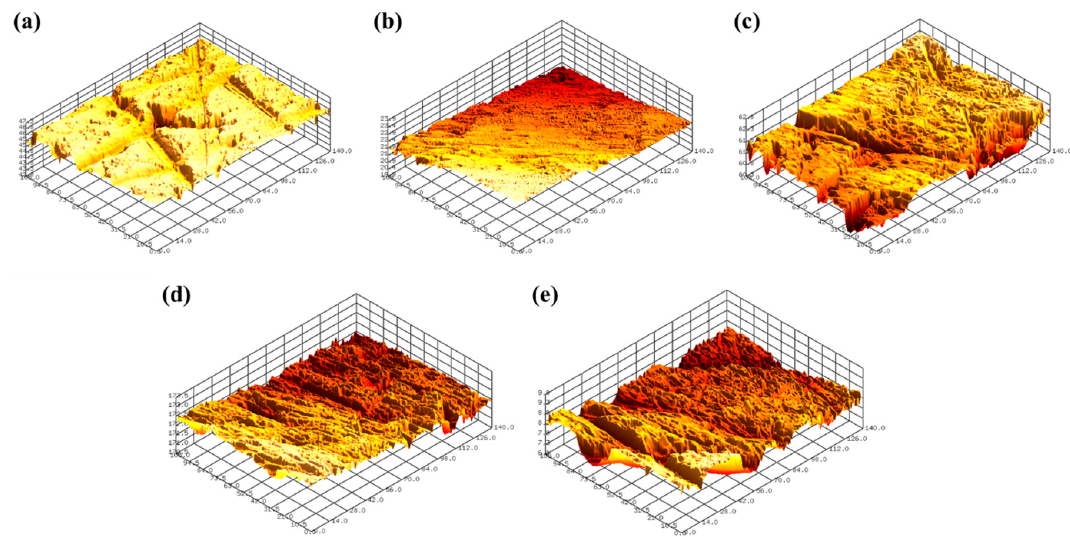
Figure 12. Representative 3D surface profiles of SS304 after FB-CMP for chemical solutions containing various oxalic acid concentrations: ( a ) 0 wt % (Sa 0.280 µ m), ( b ) 0.2 wt % (Sa 0.101 µ m), ( c ) 0.4 wt % (Sa 0.178 µ m), ( d ) 0.6 wt % (Sa 0.180 µ m) and ( e ) 0.8 wt % (Sa 0.246 µ m).